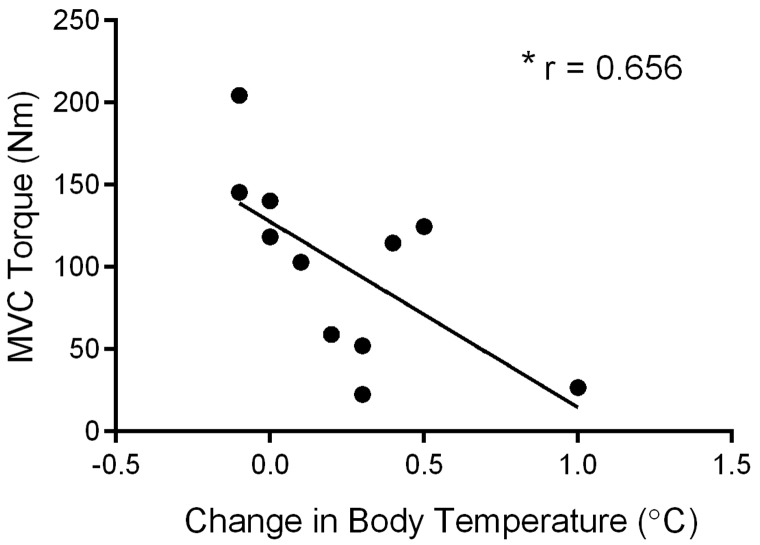
Figure 5. Relationship between body temperature and post-exercise maximal voluntary contraction (MVC). Following body-weight support treadmill at room 21°C (BWSTroom),lower MVC torque was significantly correlated with increases in body temperature. *Indicates a significant (p < 0.05) correlation.